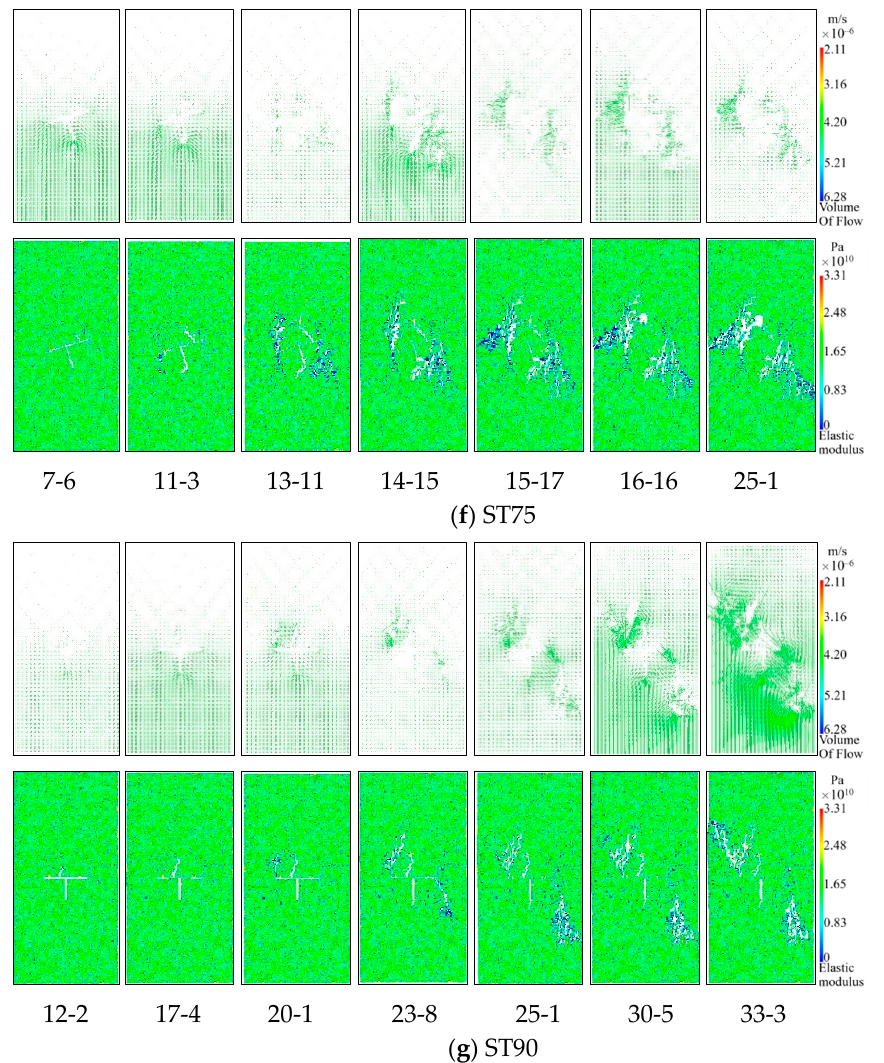
Figure 14. Flow vector and elastic modulus simulation results of T-shaped fracture sandstone specimens under hydro-mechanical coupling. Table 5. Comparison of test and simulation results of the permeability characteristic points of sandstone specimens.